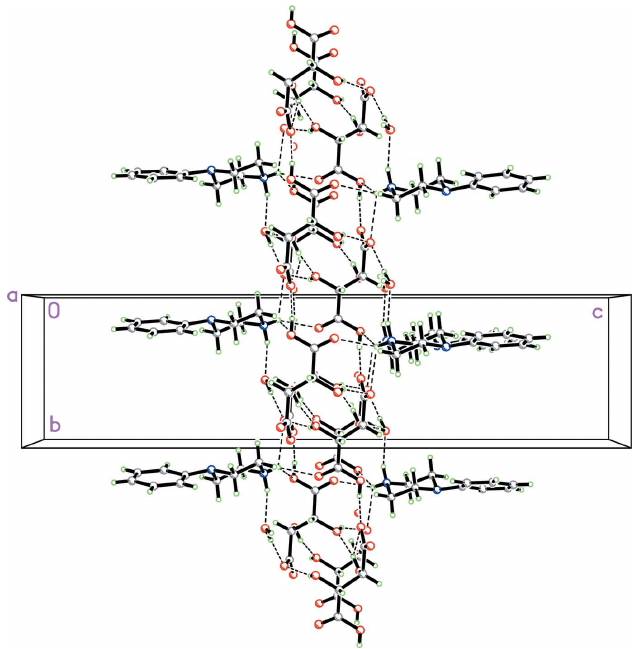
Figure 26 Packing diagram for 11 viewed along the a axis where multiple N—H (cid:2)(cid:2)(cid:2) O and O—H (cid:2)(cid:2)(cid:2) O hydrogen bonds involving the phenylpiperazinium NH 2 group, the tartarate anion and water molecule of crystallization combine to form a three-dimensional network.